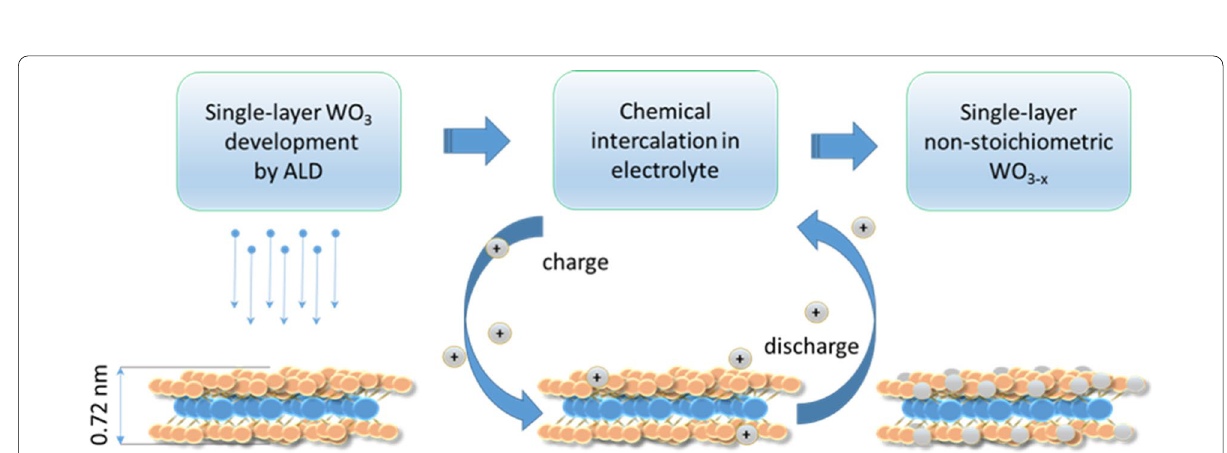
Fig. 9 Enhancement of non-stoichiometry in monolayer WO 3 film developed by ALD via intercalation/de-intercalation